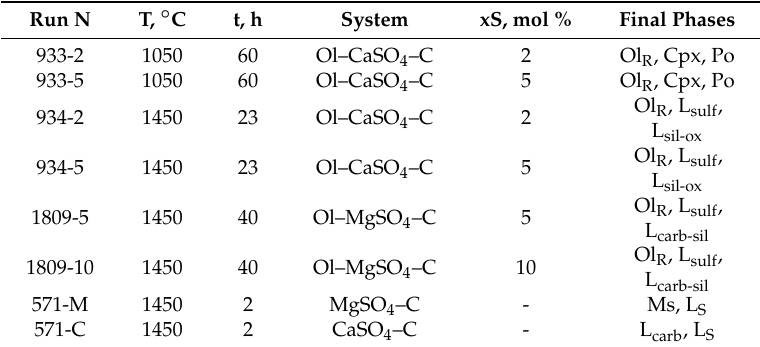
Table 2. Experimental conditions and results.